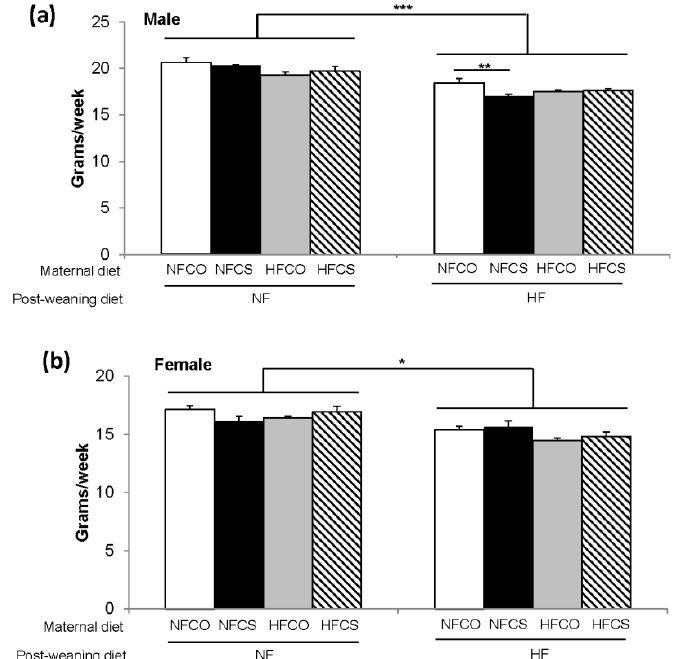
Figure 2. Average food intake during the 6-week post-weaning feeding. ( a ) Represents males and ( b ) represents females. Open bar: NFCO, closed bar: NFCS, grey bar: HFCO, hatched bar: HFCS. n = 12 for the postnatal NF groups and n = 16–20 for the postnatal HF groups for each sex. Data were analyzed using the general linear model. Values represent means ± SEM. *, p < 0.05; **, p < 0.01; ***, p < 0.001; NF: normal fat; HF: high fat; CO: untreated control without choline; CS: choline supplemented.